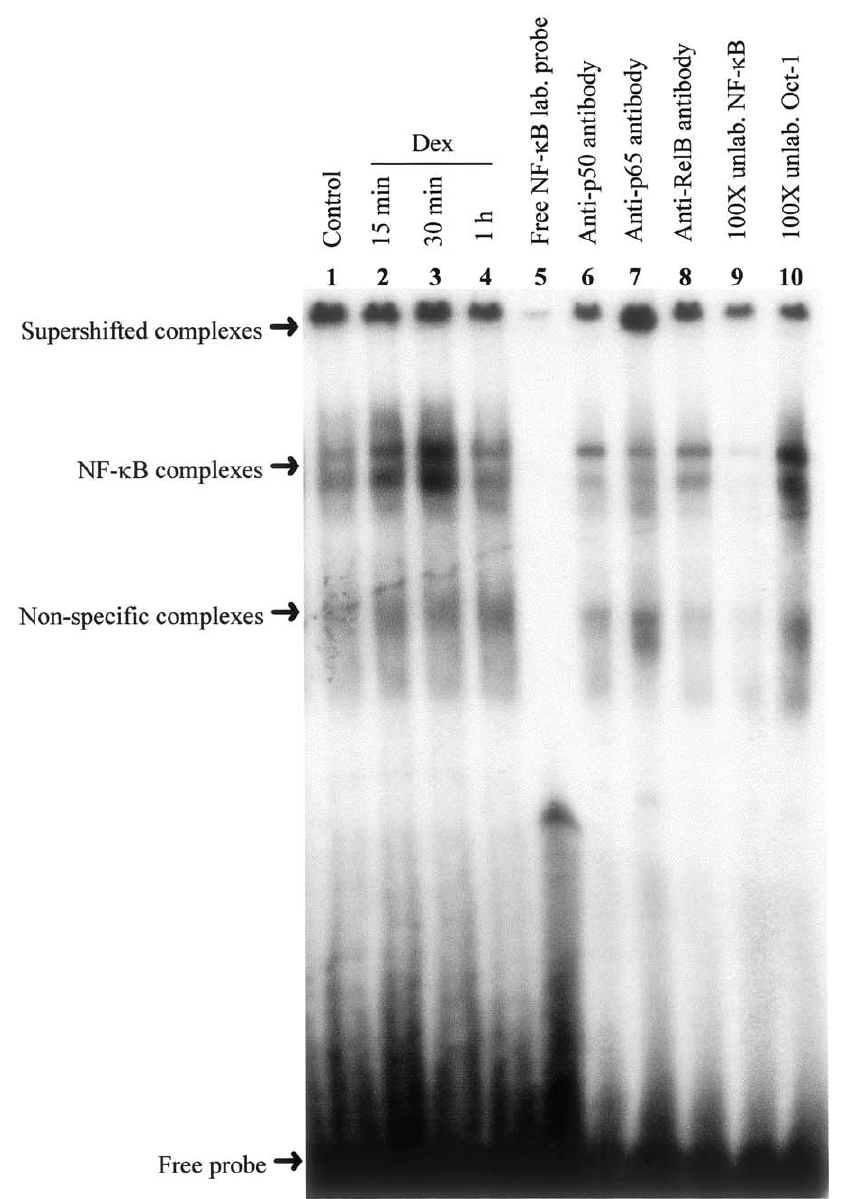
FIG. 5. Activation of NF- k B by Dex. CCRF-CEM cells were treated (lanes 2 (cid:1) / 4) or not (control, lane 1) with Dex (1 m M), for the indicated periods. Nuclear extracts were prepared and subjected to electrophoretic mobility shift assay analysis as described in Materials and methods. Supershift experiments were performed using antibodies against p50 (lane 6), p65 (lane 7) or RelB (lane 8) in nuclear extracts from cells treated with Dex, for 30 min. Competition experiments with a 100-fold excess of unlabelled competitor probe relatively to the labelled NF- k B probe were also performed using nuclear extracts from cells treated with Dex, for 30 min (lanes 9 and 10). The results are representative of three independent